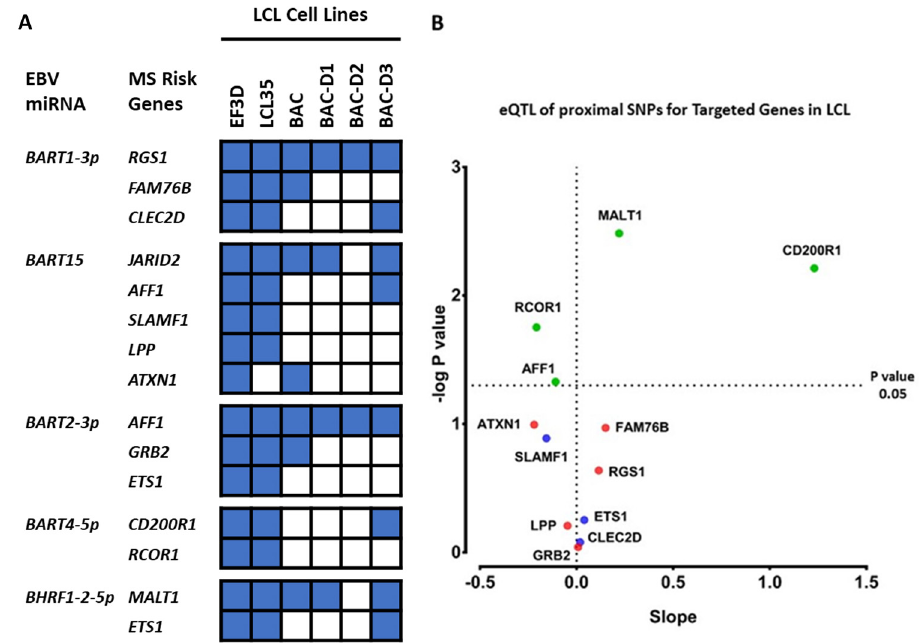
Figure 4. EBV miRNAs’ targets among MS risk genes. ( A ) shows MS risk genes which are targeted by EBV miRNAs and the replication of these interactions in different LCL cell lines (blue fill). LCL cell lines EF3D-AGO2, LCL35 and LCL-BAC (transformed with the plasmid which contains EBV-B95-8 genome) contain complete EBV miRNA profile. LCL-BAC-D1, LCL-BAC-D2 and LCL-BAC-D3 cell lines lacking miR-BHRF1-1 , miR-BHRF1-2 , or miR-BHRF1-3 , respectively. The miRNA:mRNA interactions were deemed to be most accurate if verified by PAR-Clip data in at least two of three LCL PAR-CLIP datasets with a full EBV 95.8 miRNA profile (EF3D, LCL35 and BAC). PAR-CLIP data for mutant EBV strain cell lines were used for further evaluation of BHRF1-1 , BHRF1-2 , and BHRF1-3 targets. ( B ) shows the significance of eQTL effect of MS risk SNPs on genes which targeted by EBV miRNAs. Red dots represent insignificant eQTLs at a cutoff p value of 0.05. Blue dots represent the MS risk genes that have an EBNA2 binding site collocated with the risk SNP. Green dots represent the significant eQTLs at a cutoff p value of 0.05 which have an EBNA2 binding site collocated with the risk SNP. Slope means the effect of risk allele relative to protective allele on